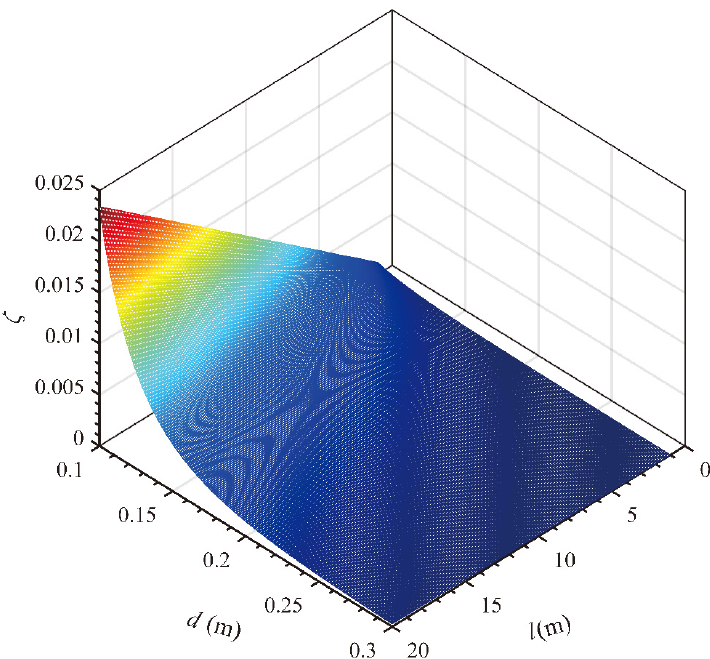
Figure 17. Effects of the pipeline length and inner diameter, l and d , on the damping ratio, ζ